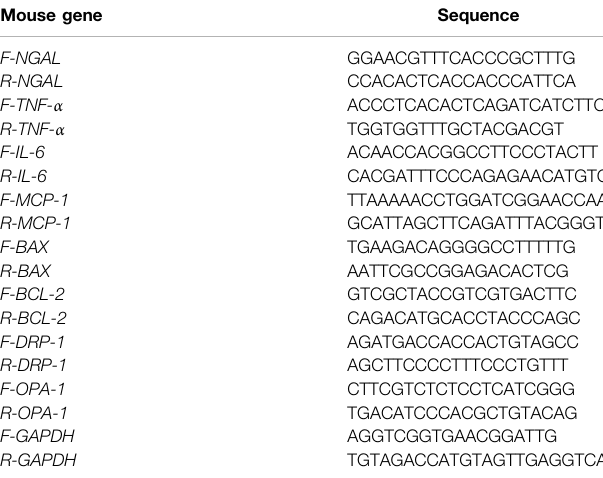
TABLE 1 | Sequences of the primers for quantitative real-time